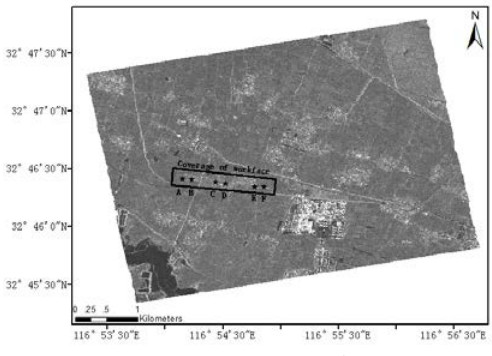
Figure 4. The amplitude map of study